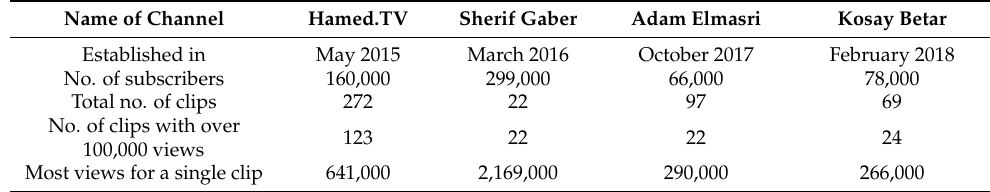
Table 1. Popular YouTube Channels by Arab non-believers and freethinkers, December 2020. Name of